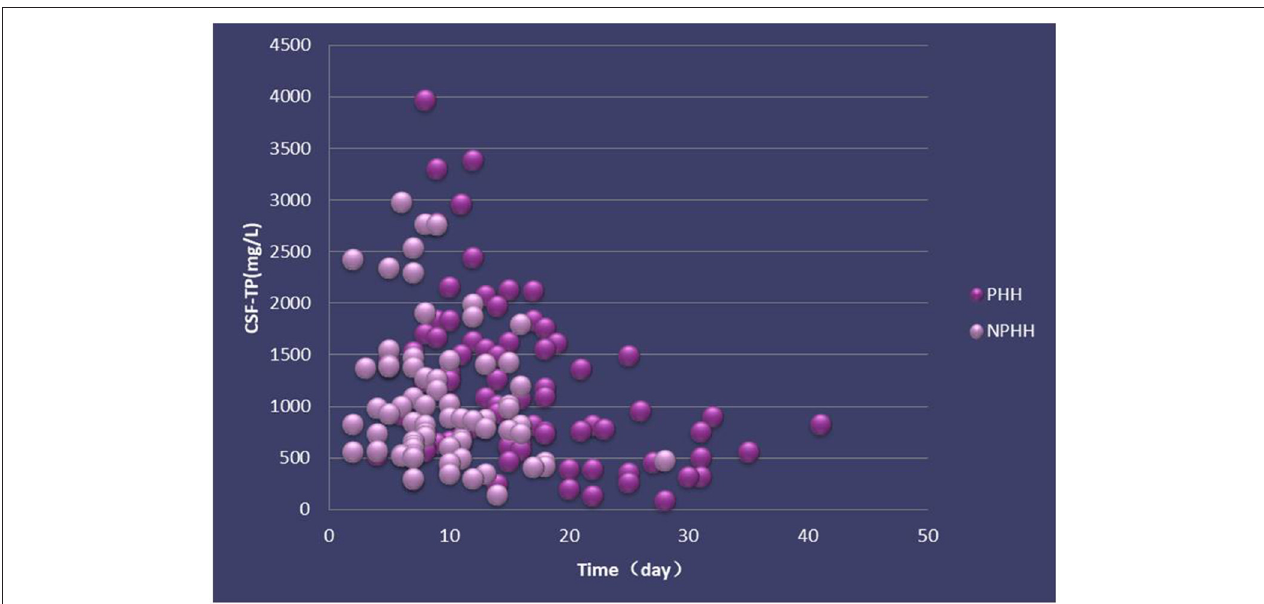
FIGURE 2 | Distribution of CSF-TP in PHH and NPHH groups. X-axis:0 means the beginning of the disease.